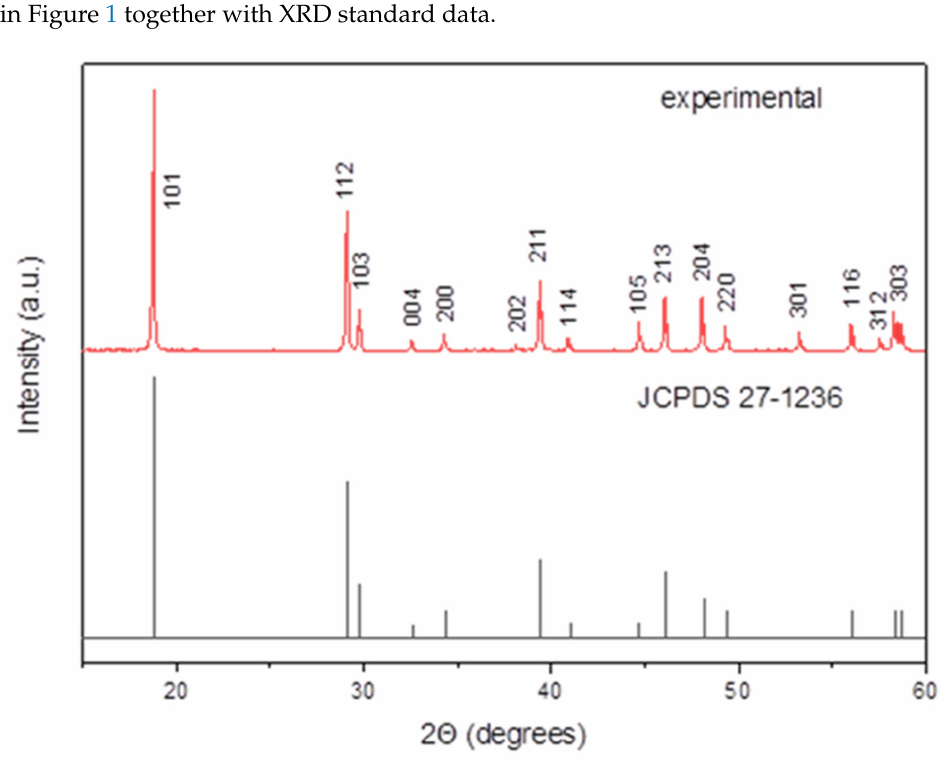
Figure 1. XRD pattern of the LiGdF 4 sample and XRD standard of LiGdF 4 . The LiGdF 4 samples are transparent in near IR and visible spectral ranges and have intensive absorption bands in UV due to 4f-4f transitions from the 8 S 7/2 ground state of the Gd 3+ ions to the 6 P j , 6 I j, and 6 D j excited ions, being outside of the said spectrum range (Figure